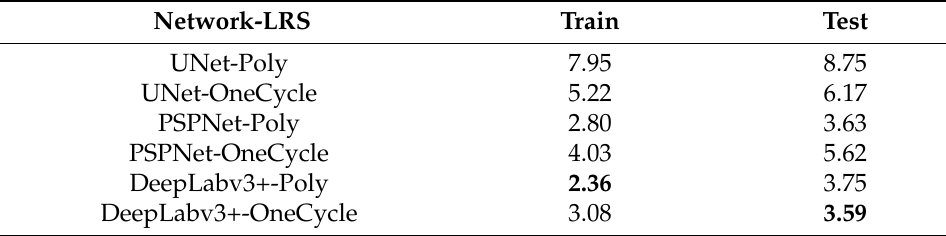
Table 4. The mean absolute error (MAE) in pixels achieved by different architectures, obtained over all the layers calculated on our data splits: train and test. Numbers in bold represent the best results.